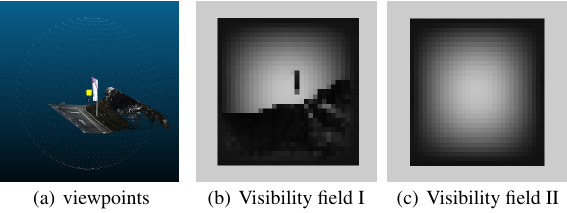
Figure 1. Hemispherical visibility field of a traffic sign.